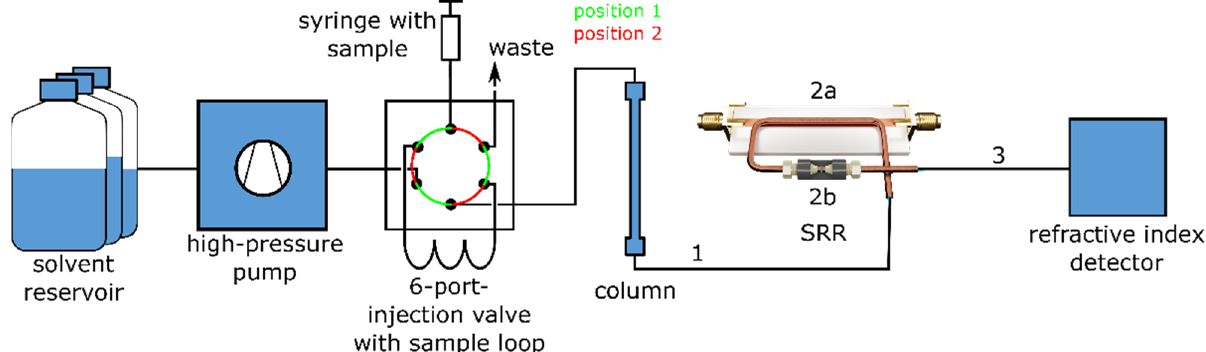
Figure 6. Schematic layout of the Knaur HPLC with the built-in SRR. The dead volumes between the HPLC column and the refractive index detector are as follows. (1) 30 cm capillary with inner diameter of 250 µ m giving a dead volume of 14.7 µ L, (2a) SRR capillary volume of 8.6 µ L, (2b) split capacitor volume of 2.3 µ L, and (3) 50 cm connecting capillary with inner diameter 250 µ m giving a dead volume of 24.5 µ L.